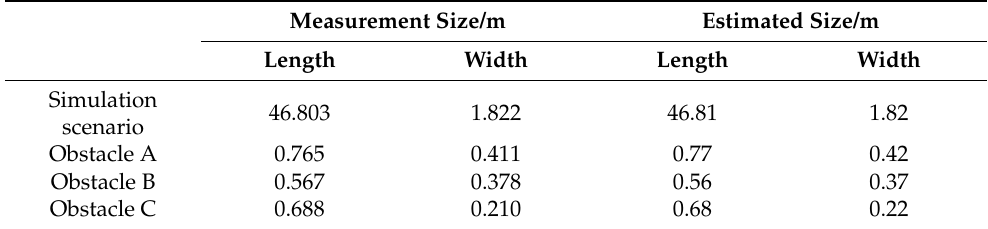
Table 4. The measurement results of the laser rangefinder and the corresponding estimated values by the constructed 2D occupancy grid map.